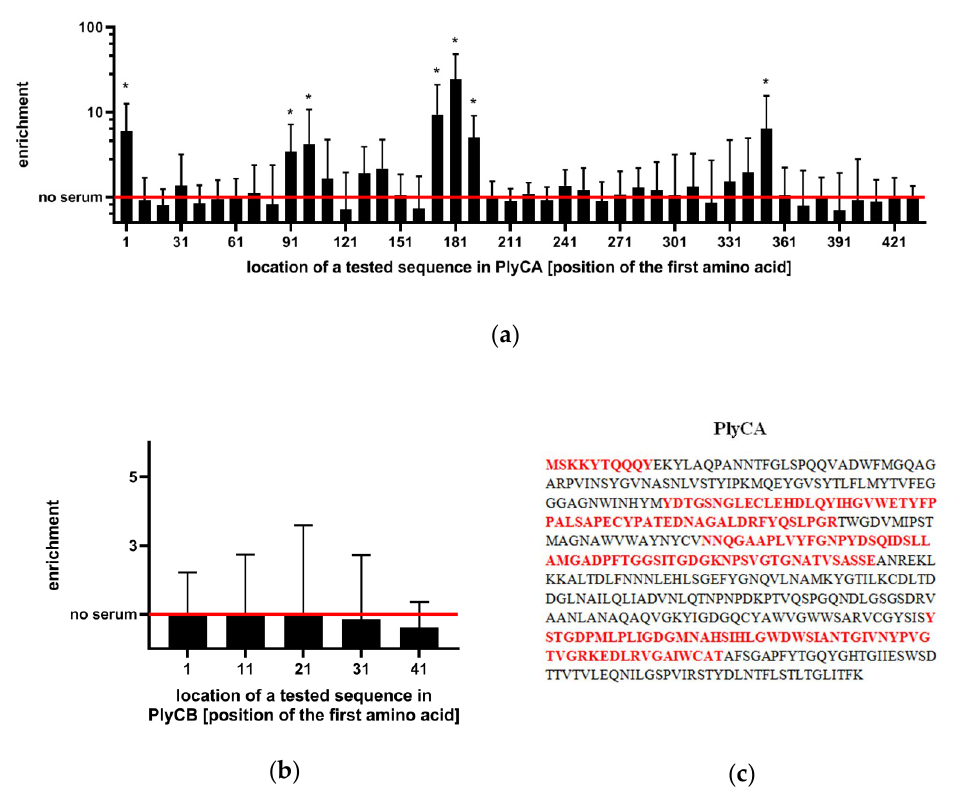
Figure 3. Immunogenic regions in PlyC. ( a ) Enrichment ratios within PlyCA subunit. ( b ) Enrichment ratios within PlyCB subunit. Red lines in panels a and b represent the signal of the ‘input sample’ (that is: the library before immunoprecipitation), normalized as 1.0 ( c ) Estimated immunogenic regions in PlyCA sequence (in red) are presented. The immunogenicity of PlyC regions was defined in the reaction of a phage display library containing PlyC-derived oligopeptides (10 aa shift) with murine sera. Mice were immunized with PlyC (100 µg/mouse in 0.2 mL), and PlyC-specific serum was used for immunoprecipitation. NGS was used to identify the immunoprecipitated fraction of the phage display library. The enrichment ratio of PlyC-representing oligopeptides after immunoprecipitation is presented, indicating the relative strength of interaction. *, adj. p < 0.01 from the comparison of normalized signals between the immunoprecipitated sample and the input sample, for each oligopeptide. Datapoints represent the average and the SD of 6 biological replicates ( n = 6). Two technical replicates were completed.